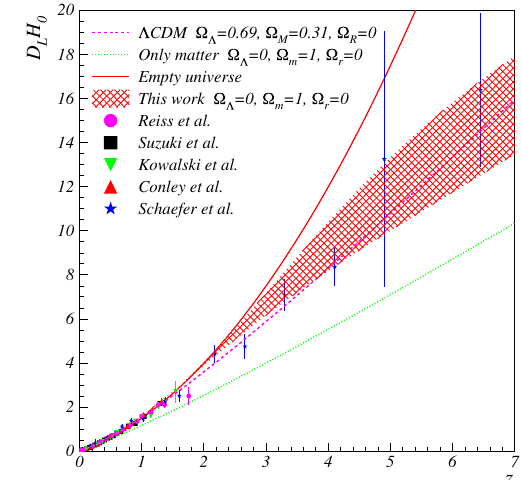
Fig. 3 Apparent magnitudes of γ -ray bursts (star symbol) and super- novae (other symbols). Larger D L H 0 values correspond to fainter observed events. The dashed line is the expectation from the Λ CDM model. The dotted line is the case of a universe with only matter and with the traditional approximation of homogeneity and isotropy. The continuous line shows the case of an empty Universe. The band is the present work (universe containing only baryonic matter, with gravity field partially trapped in massive systems due to field self-interaction). It has no free parameters adjusted to the γ -ray or supernova data